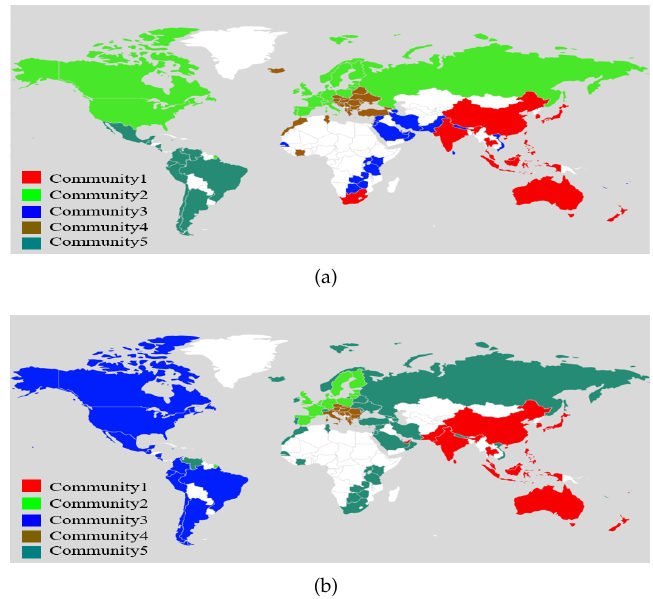
Figure 3. ( a ) Node communities found in layer group 1 by MSFE; ( b ) Node communities found in layer group 2 by